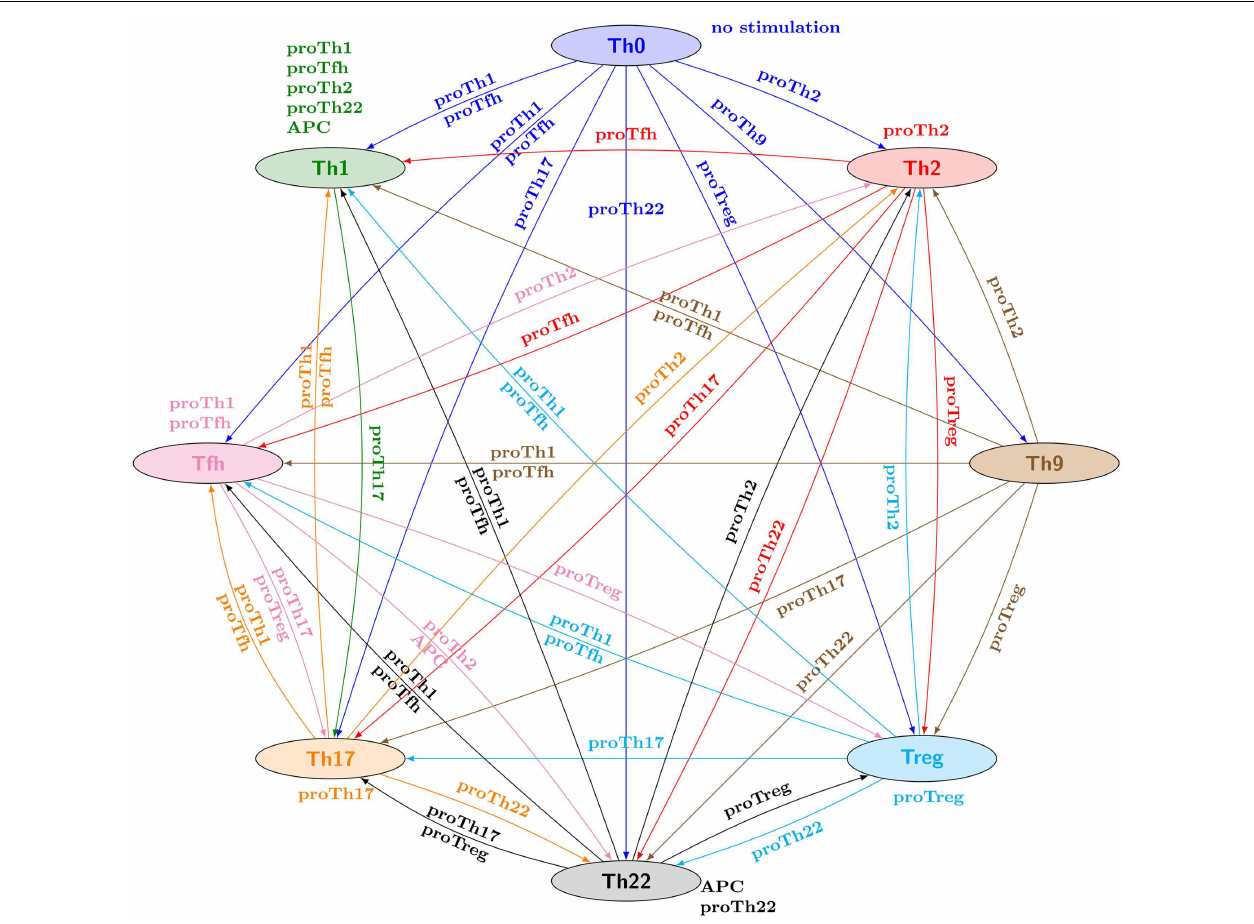
imply the stability of the targetTh subtype, since NuSMV-ARCTL considers that a property is true if and only if it is verified by the whole set of states in the initial conditions. Hence, if at least one state associated with a given subtype points to a state not associated with this subtype (for given input conditions), then the stability of theTh subtype is not represented (see for example,Th9 subtype, which is not considered stable under proTh9 input